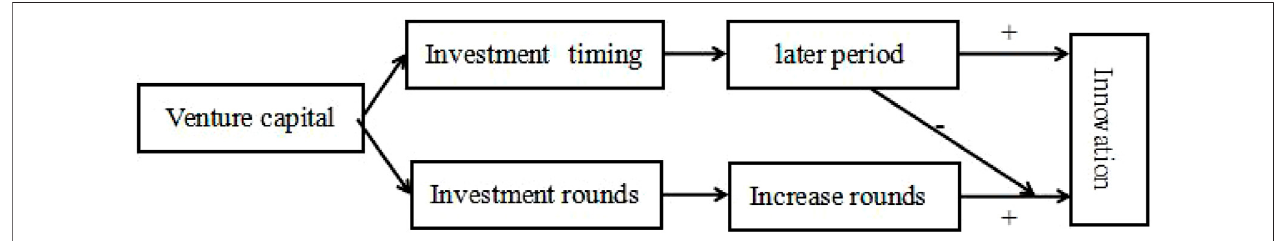
FIGURE 1 | The path and result of venture capital in fl uencing enterprise